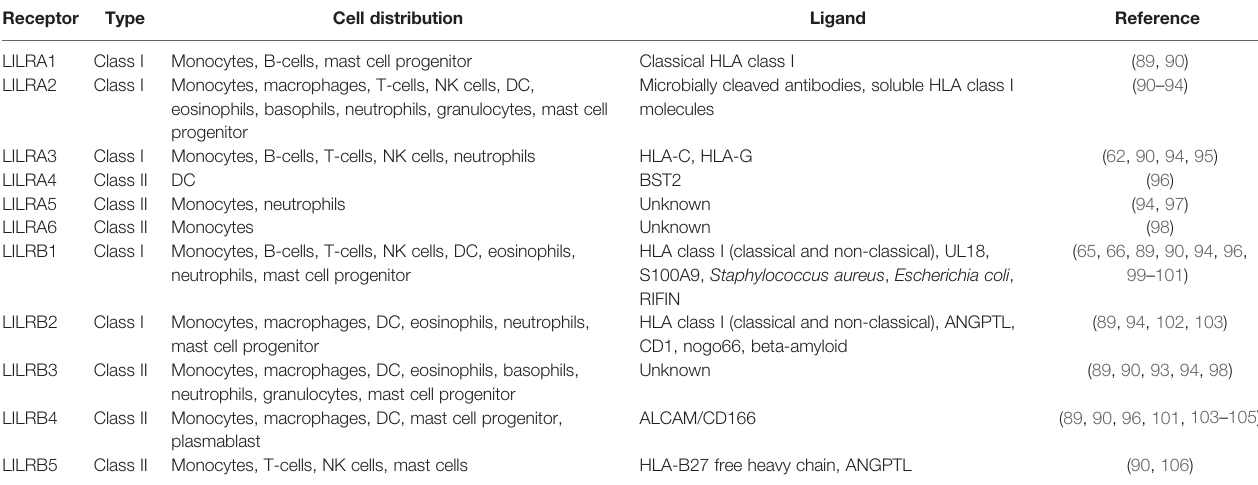
TABLE 1 | Cell distribution and ligands of human LILR